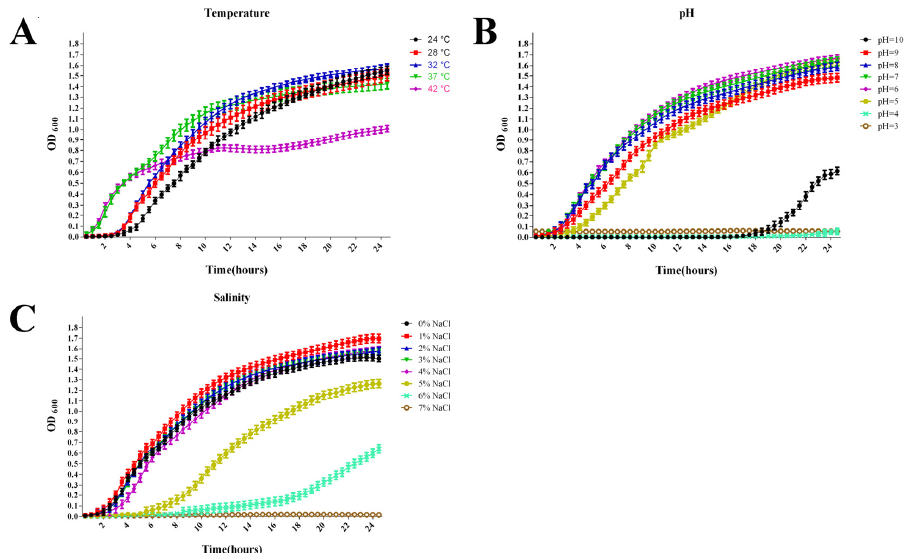
Figure 4. Growth (OD 600 ) of strain GDZQ201912 at different temperatures ( A ), pH ( B ), and salinities ( C ).